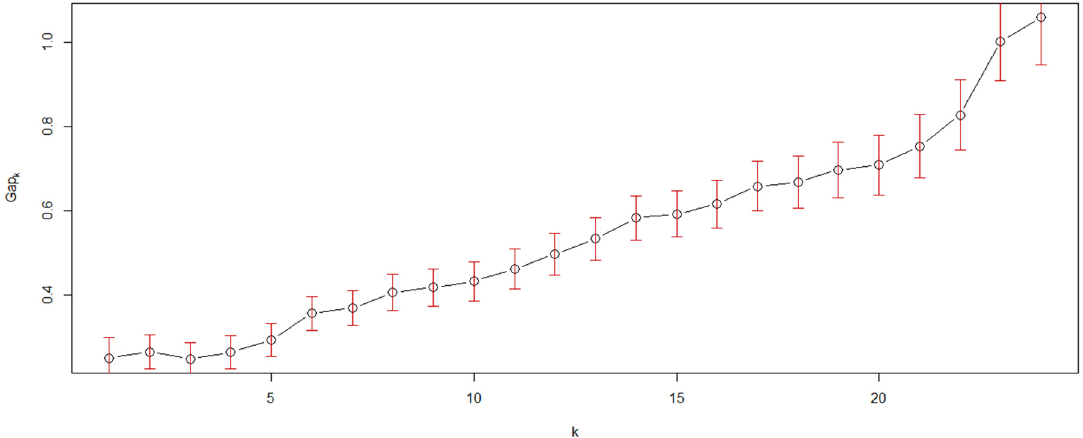
Figure 2. Gap k and its standard deviations came from 10,000 Monte Carlo samples that were cal- culated to estimate the number of clusters k, k from 1 to 24.